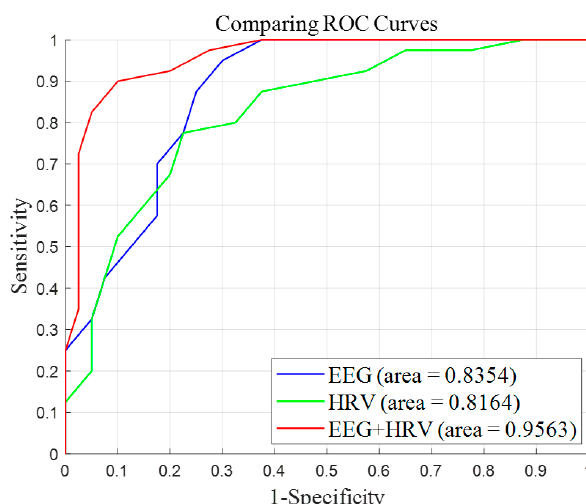
Figure 12. Average ROC curves of the five-fold cross-validation for the support vector machine (SVM) classifiers using the EEG, HRV, and EEG and HRV features. The blue line represents the EEG model (features: nLAP, nRAP, APA, BPA), the green line represents the HRV model (features: mRR, LF, HF, LF/HF), and the red line represents the EEG and HRV model (features: nLAP, APA, HF, LF/HF).